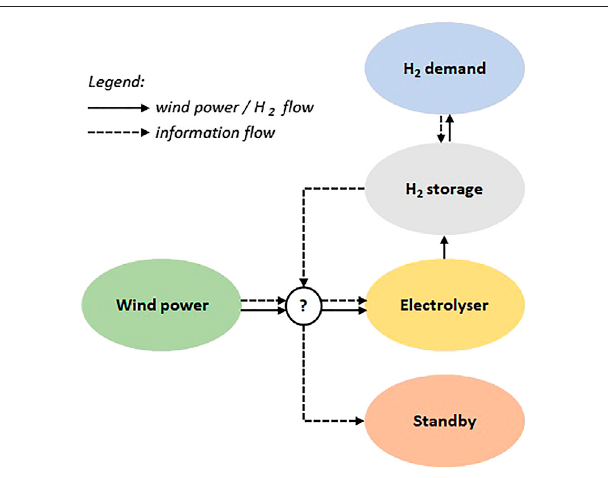
FIGURE 2 | Schematic diagram of the dynamic PtH 2 plant